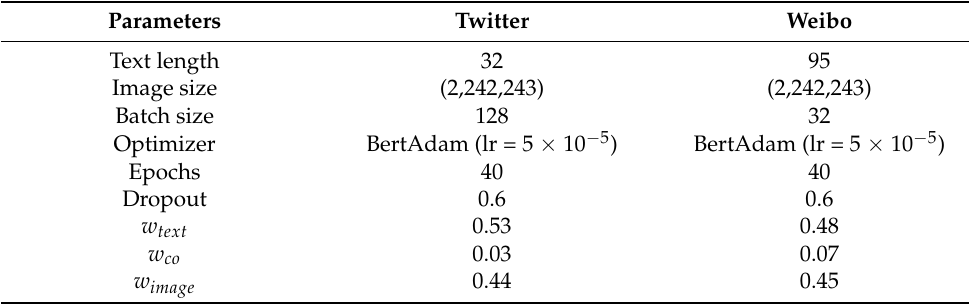
Table 3. Parameter